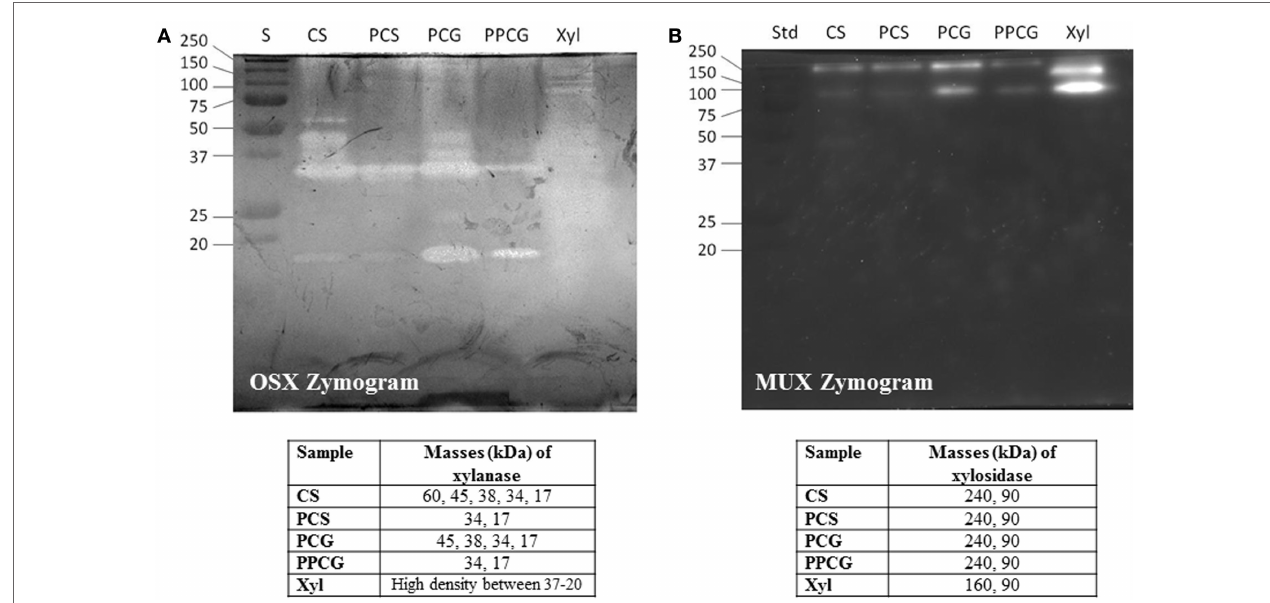
FigUre 3 | sDs-Page (12%) and zymogram of WsUcF1 (a) endoxylanase activity, (B) β -xylosidase activity . Lane S, precision plus protein standards (BioRad); Lane CS, corn stover; Lane PCS, pretreated corn stover; Lane PCG, prairie cord grass; Lane PPCG; pretreated prairie cord grass.